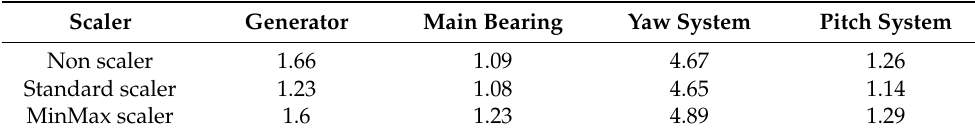
Table 4. Learning accuracy results according to the scaler.